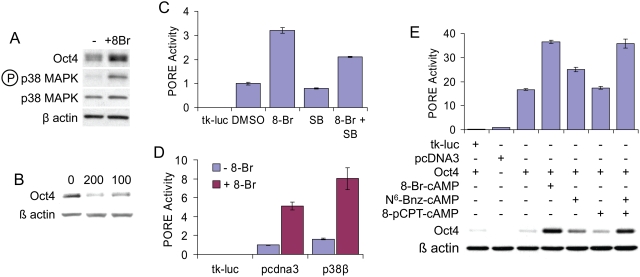
Regulation of Oct4-PORE activity by an 8-Br-cAMP-responsive pathway coupled to p38 MAP kinase.(A) P19 cells treated with 1 mM 8-Br-cAMP for 1 hour followed by analysis of Oct4 expression and p38 MAP kinase phosphorylation. (B) Treatment of P19 cells with indicated nM concentrations of the p38 MAP kinase inhibitor SB202190 for 30 minutes, followed by western blotting. (C) P19 cells were transfected with control vector (tk-luc) or PORE reporter, followed by overnight treatment with indicated combinations of 0.5 mM 8-Br-cAMP and 200 nM SB202190. (D) Luciferase assay in P19 cells following transfection with tk-luc or PORE reporters in combination with empty vector (pcDNA3) or p38β MAPK expression vector, and overnight treatment with or without 0.5 mM 8-Br-cAMP. (E) Luciferase assay and western blot analysis of 3T3 cells following transfection with PORE reporter and overnight treatment with indicated cAMP analogues.